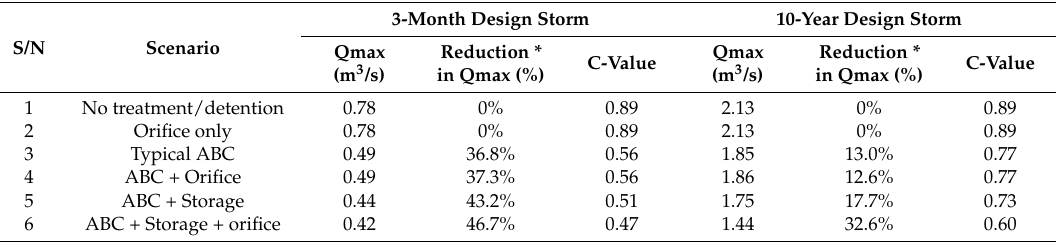
Table 4. Comparison of the outflow and effective C-value results of the precinct and alternative scenarios for the 3-month and 10-year design storms.